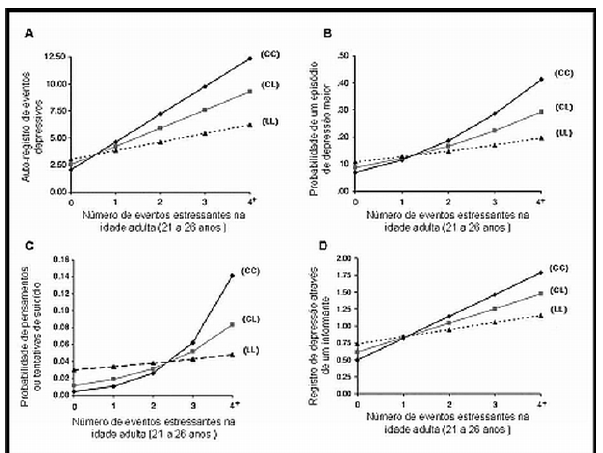
Figura 2. Análise de regressão múltipla para estimar a associação entre o número de eventos estressantes na idade adulta (entre 21 e 28 anos de idade) e diferentes sintomas relacionados com a depressão avaliada na idade de 26 anos de acordo com o tipo de genótipo do transportador